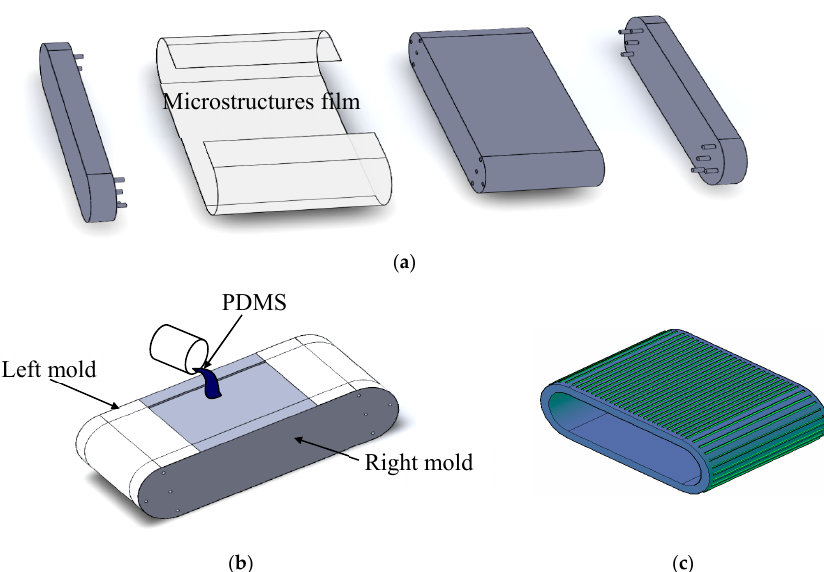
Figure 5. Multi-layer Coated Casting: ( a ) exploded view, ( b ) combination diagram and casting operation, and ( c ) finished product of microstructural Belt.